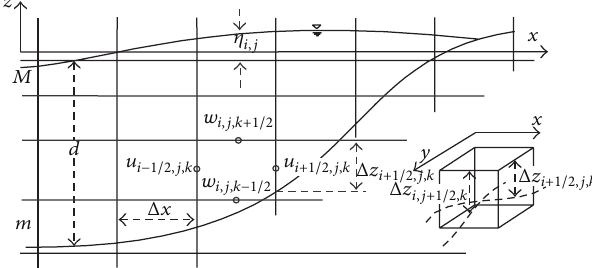
Figure 5: Discretization on the vertical